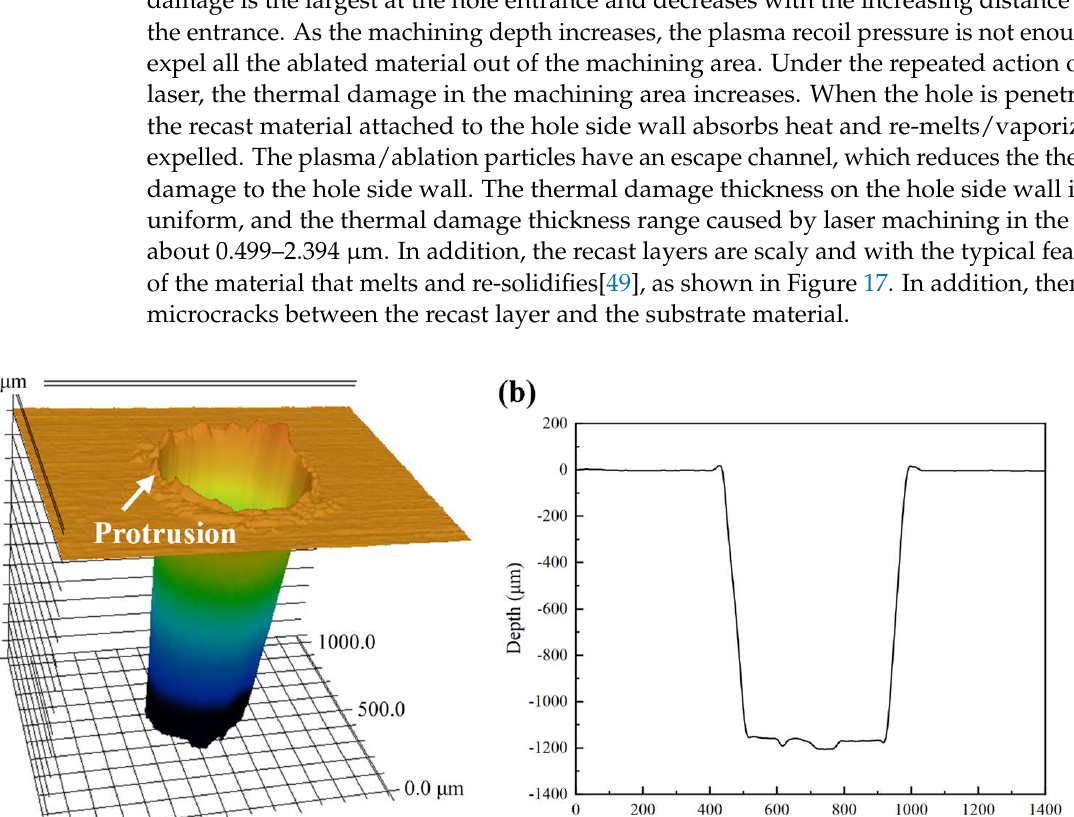
Figure 14. Hole machined by CWALSM. ( a ) 3D profile; ( b ) Cross-sectional profile.